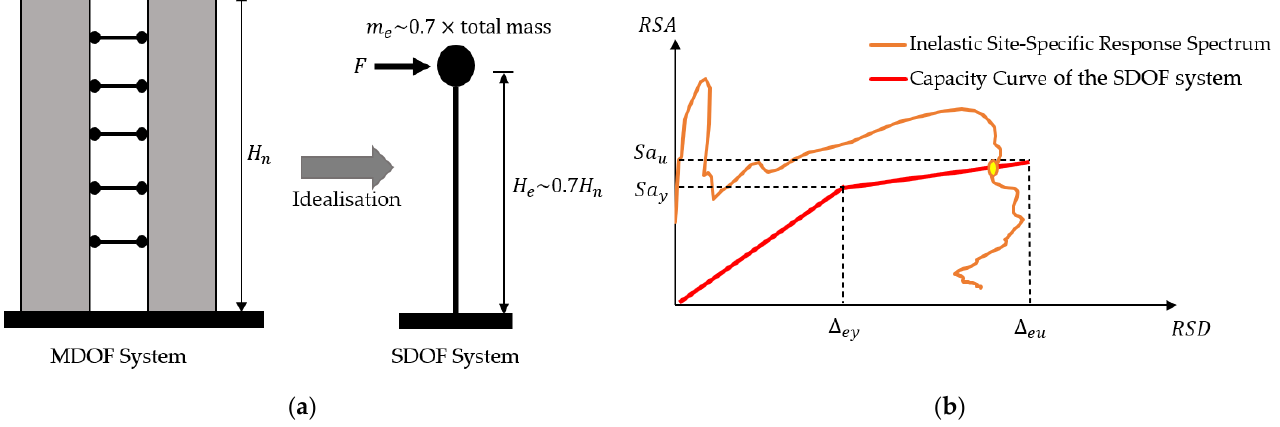
Figure 3. Displacement-based capacity spectrum method. ( a ) SDOF idealisation. ( b ) Capacity and response spectrum curves.